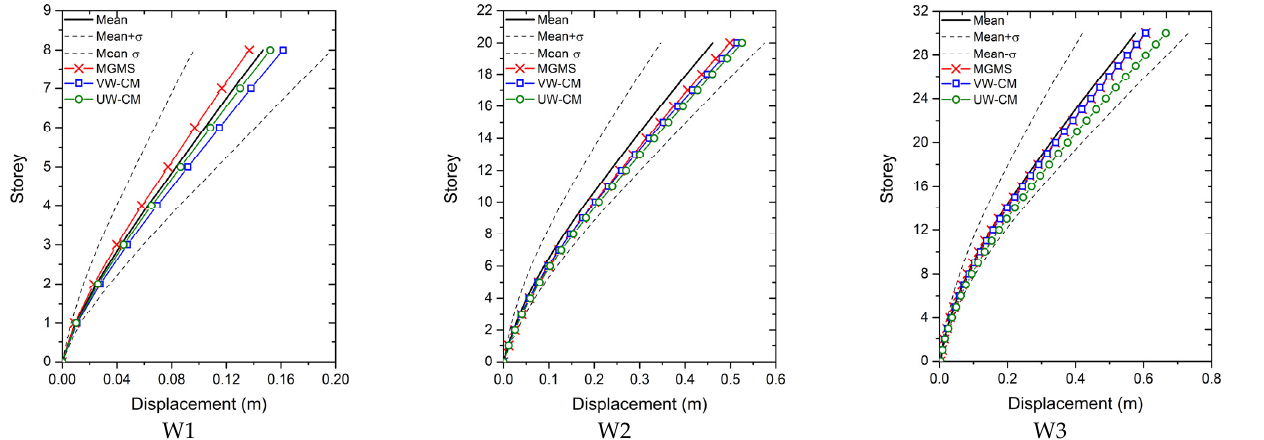
Figure 3. Comparison of the benchmark seismic demands and seismic demands computed by IGMs selected by MGMS procedures for motion set 6.